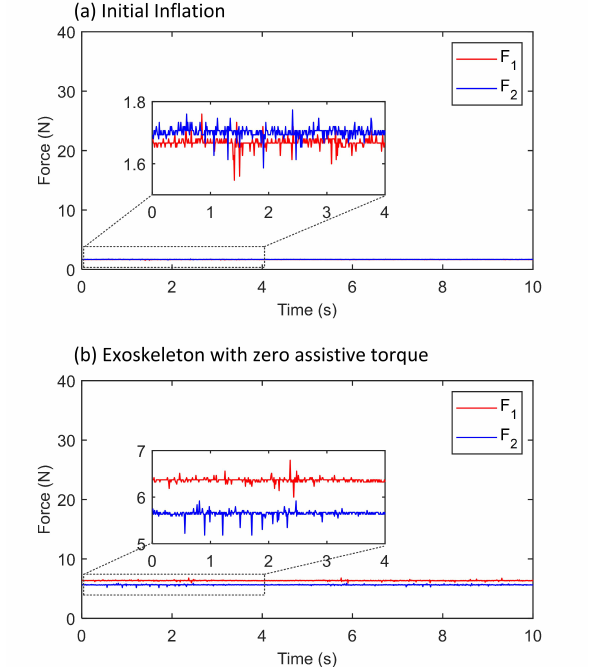
Figure 13. Force measurements during initial stage. ( a ) The soft air chamber were inflated but the exoskeleton was not worn on the subject. ( b ) The exoskeleton was worn on the subject, the thigh frame was fastened by the fastening strap, and the exoskeleton output zero torque.